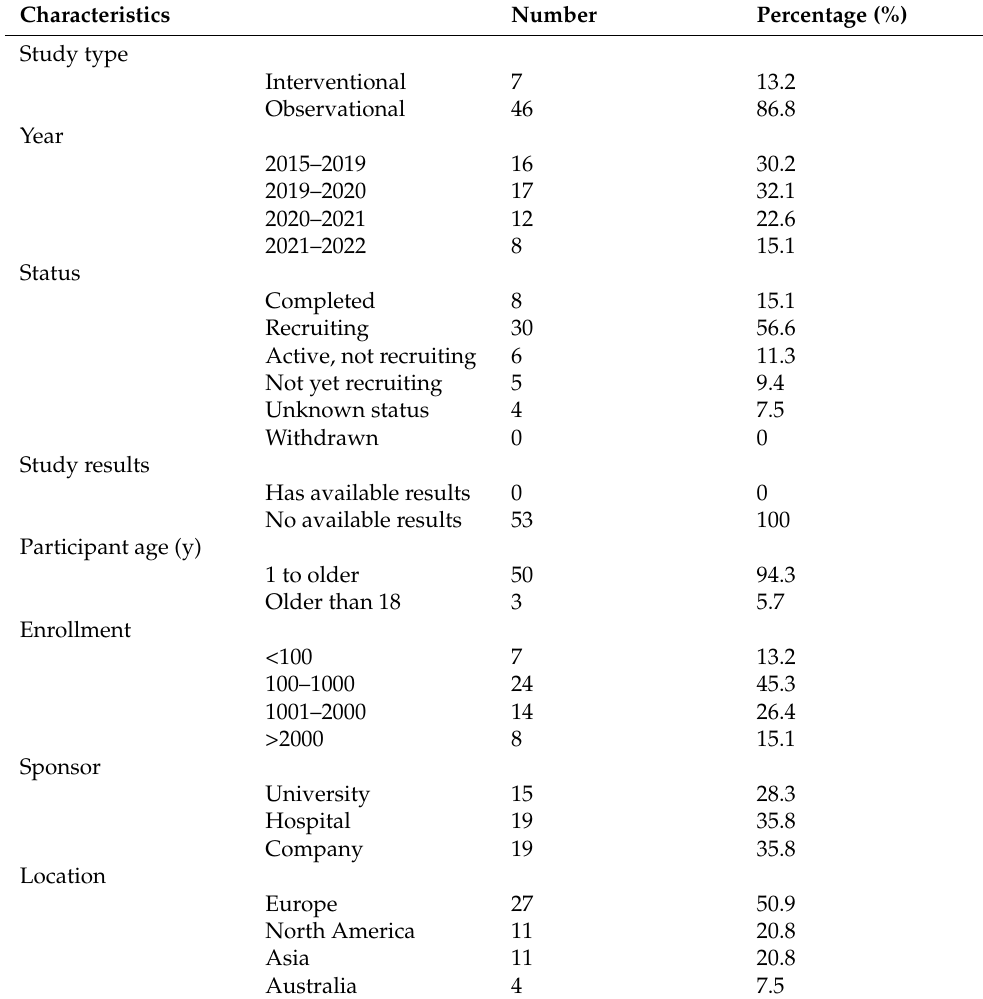
Table 1. Characteristics of included